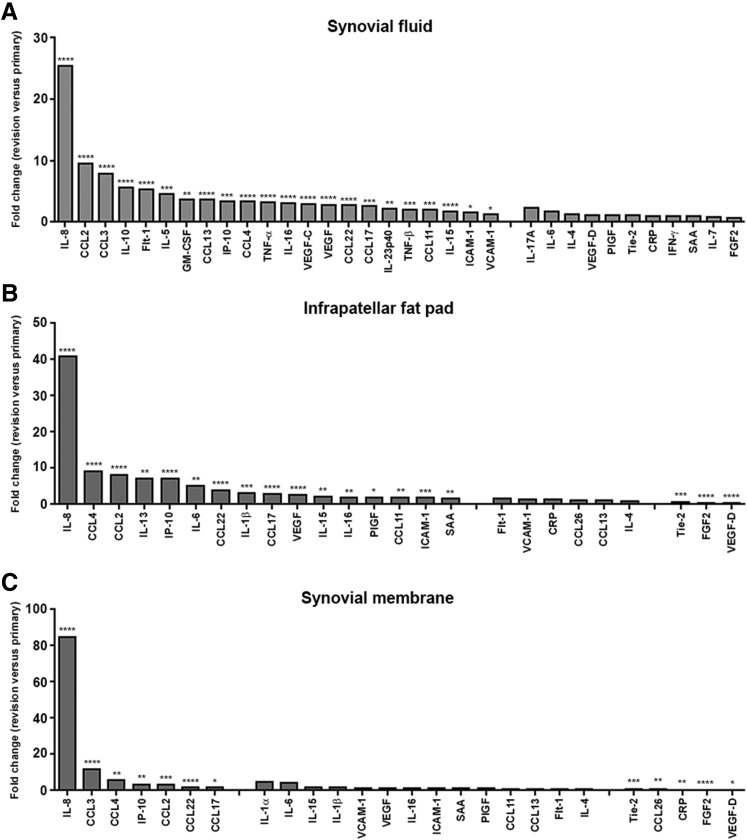
Markers of inflammation are elevated in patients undergoing revision total knee arthroplasty (TKA). Fold change in protein expression in synovial fluid (A), infrapatellar fat pad (B), and synovial membrane (C) isolated from patients undergoing revision TKA compared with patients undergoing primary TKA. Fold change was calculated using median protein expression. Significance was calculated using U-test. ∗P < 0.05, ∗∗P < 0.01, ∗∗∗P < 0.001, and ∗∗∗∗P < 0.0001 primary versus revision patients. CRP, C-reactive protein; FGF, fibroblast growth factor; Flt, Fms-like tyrosine kinase 1; GM-CSF, granulocyte-macrophage colony-stimulating factor; ICAM, intercellular adhesion molecule; IFN, interferon; IP-10, interferon gamma-induced protein 10; PIGF, placental growth factor; SAA, serum amyloid A; Tie, tyrosine kinase; TNF, tumor necrosis factor; VCAM, vascular cell adhesion molecule; VEGF, vascular endothelial growth factor.